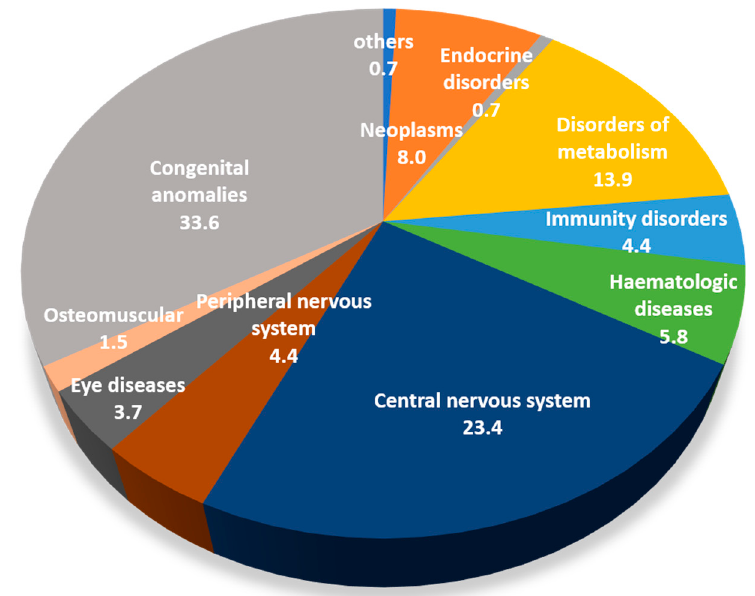
Figure 3. Percentage distribution per nosological group (ICD9-CM) of RD patients whose death occurred in paediatric age. Veneto Region rare diseases registry; 2006–2016.